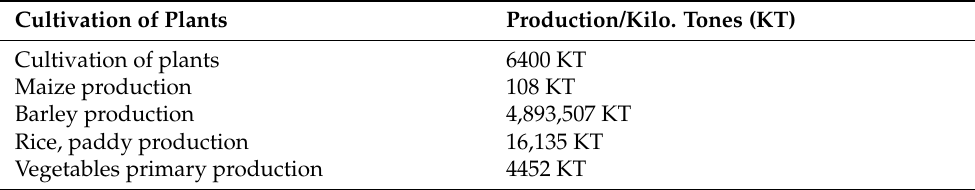
Table 1. Annual production of different crops in Egypt